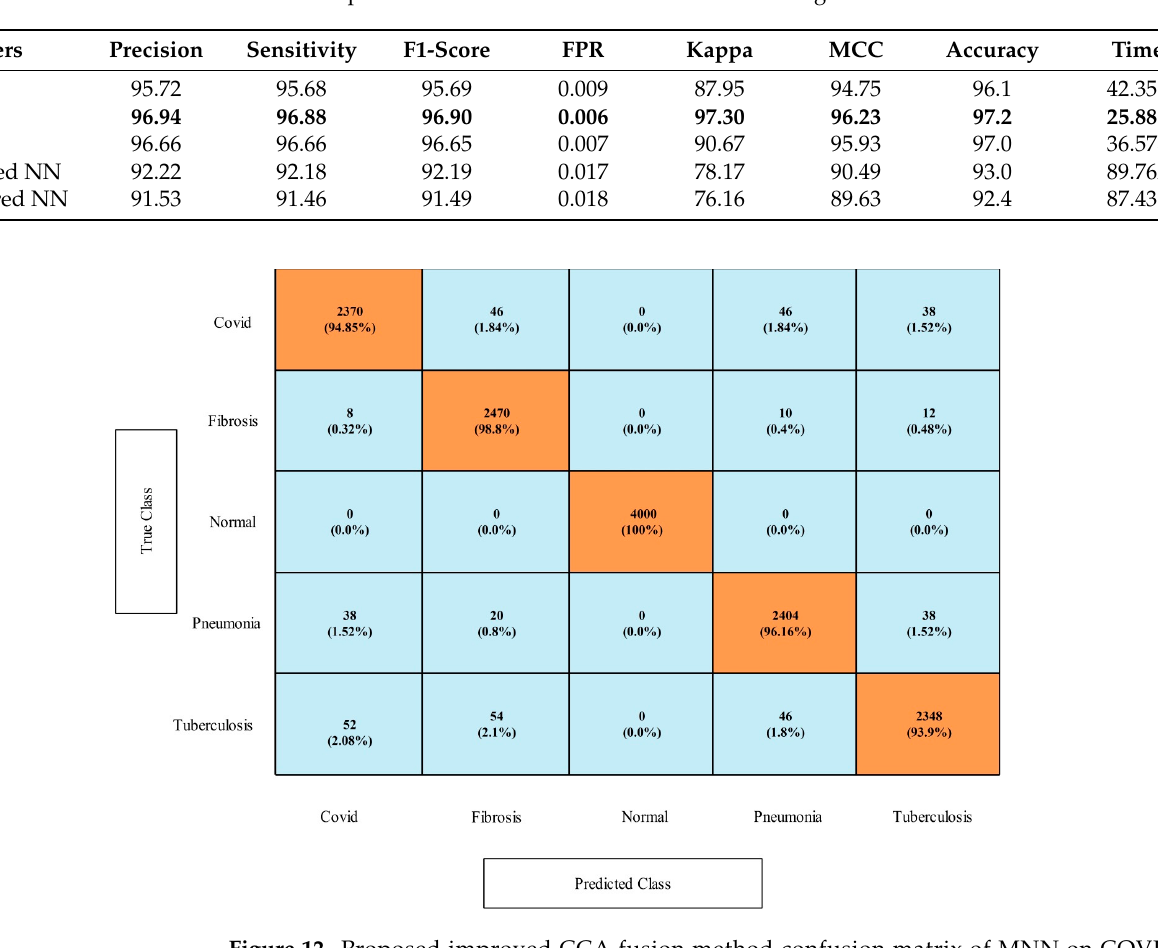
Figure 11. Confusion matrix of NNN classifier using proposed optimization on COVID-19 Lung CT Scans dataset. Table 9. Proposed fusion method results on COVID-19 Image dataset.